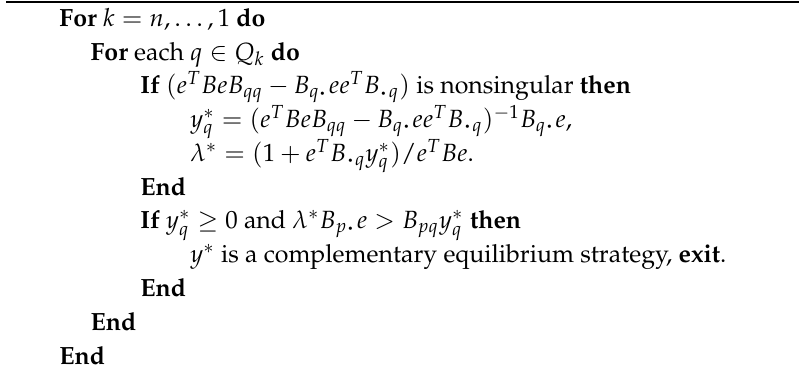
Algorithm 6: A Dense Complementary Shapley-Snow Algorithm For k = n , . . . , 1